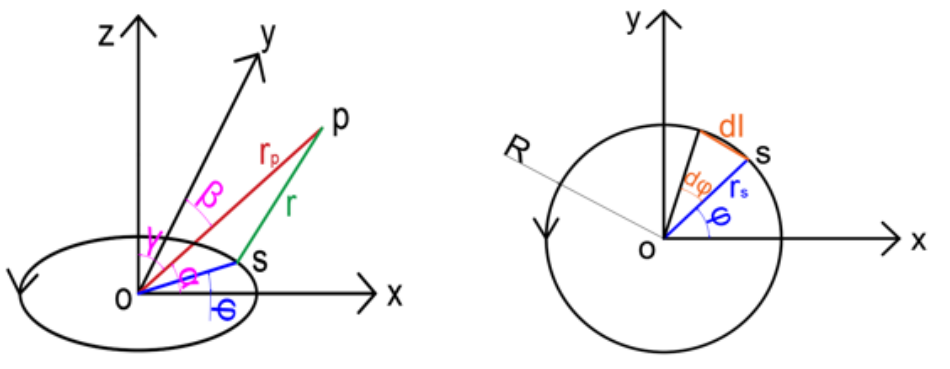
Figure 2. Establishment of the coordinate system.